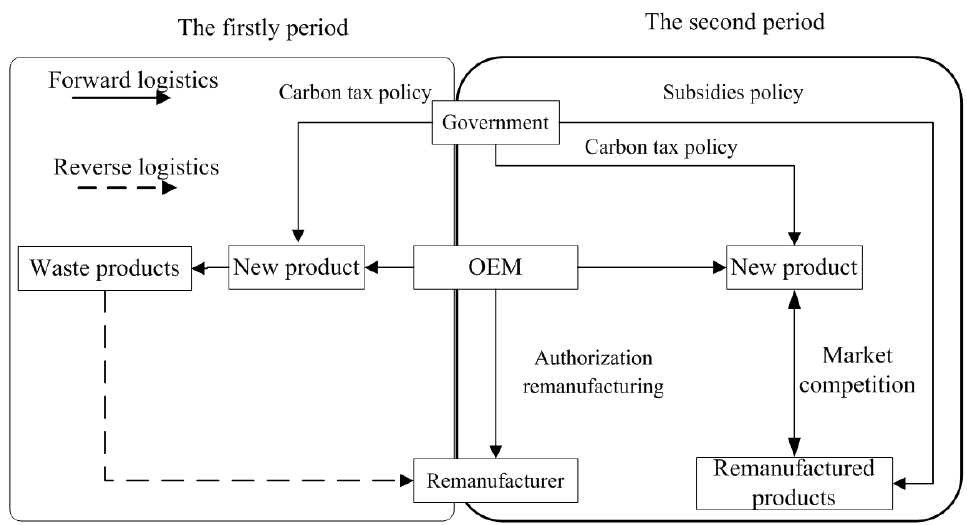
Figure 1. The game theory model of authorized remanufacturing based on government subsidies and carbon tax policies. and carbon tax policies.